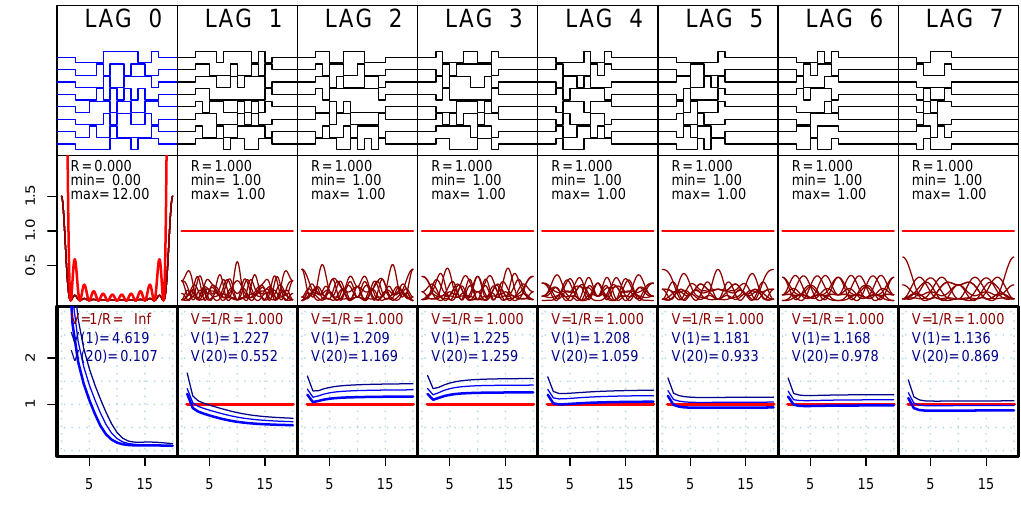
Fig. 7. Alternating code set of length 12 and type 2 introduced by Sulzer. Again the coarse analysis (red curve) represents perfect behaviour, but it seems that in integration and realistically accurate fractional lag calculations the first lags seem to behave somewhat worse than the alternating codes